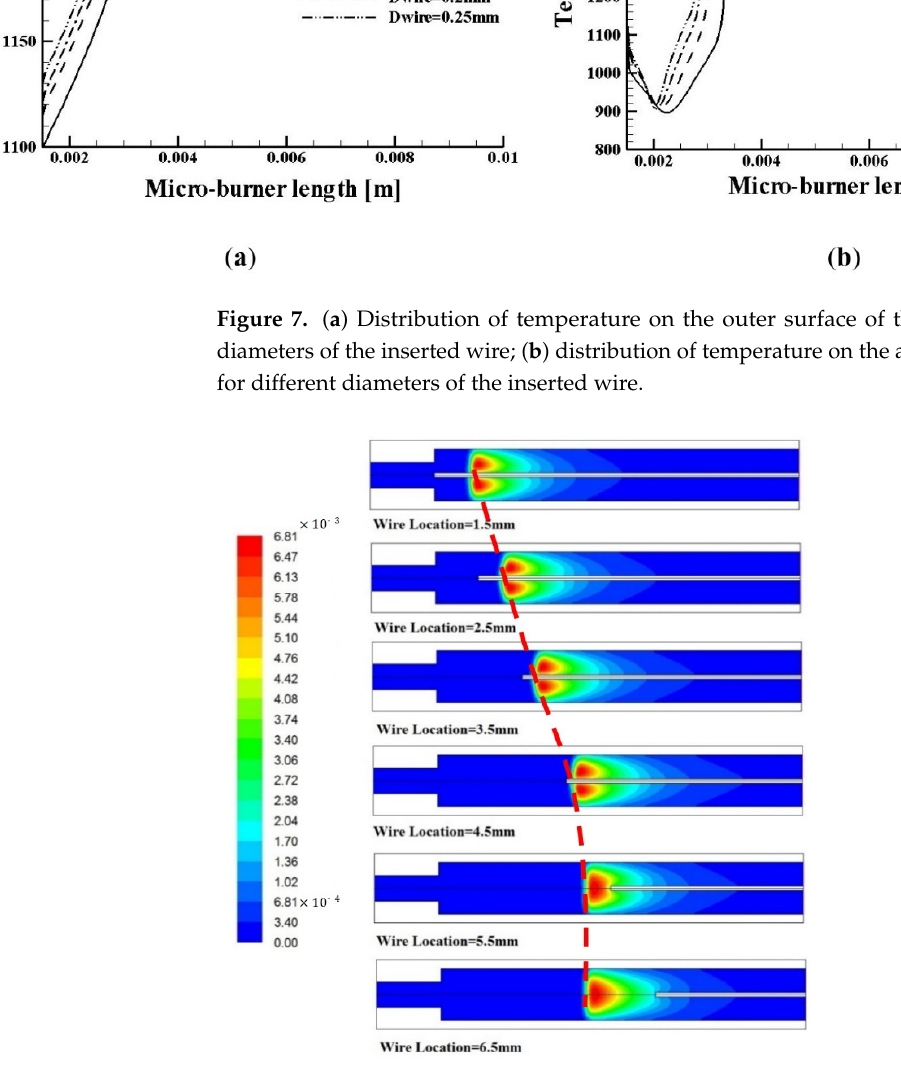
Figure 9. ( a ) The effect of wire location on temperature and methyl radical distribution on the outer surface of the wire; ( b ) The flame location versus the location of the inserted wire. Furthermore, Figure 10a demonstrates that the axial position of the inserted wire has a significant effect on temperature distribution on the micro-burner’s wall. In this regard, the closer location of the inserted wire to the backward-facing step leads to a more uniform temperature distribution, with a significantly higher average temperature level on the outer surface of the micro-burner. As seen in Figure 10a, locating the wire 1.5 mm away from the step leads to a temperature distribution level of 1155 ± 44.44 K (the mean value ± the standard deviation) along the outer wall, whereas this value worsens to 1122 ± 80.30 K and 1125 ± 125.8 K, when we increase the distance to 3.5 mm and 5.5 mm away from the step, respectively. This means that moving the flame location towards the backward-facing step (Figure 10b) provides enough room for heating up, and then for a more uniform temperature distribution on the wall using the post-flame high- temperature gases. This room for the heat transfer from the post-flame hot gases is limited